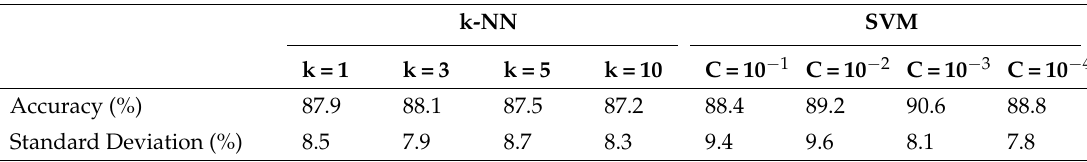
Table 4. Classification accuracy of k-NN (k = 1, 3, 10, 20) and SVM (C = 10 − 1 , 10 − 2 , 10 − 3 , 10 − 4 ) using ALL feature vector based on